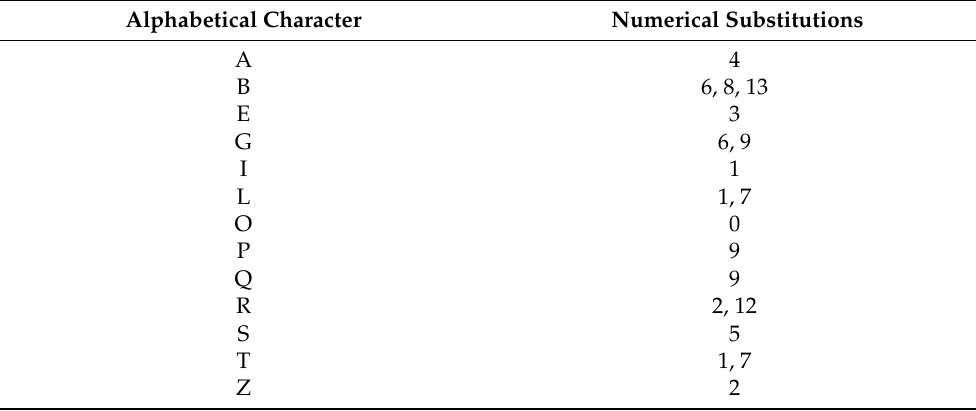
Table 1. The most common letters that have numerical